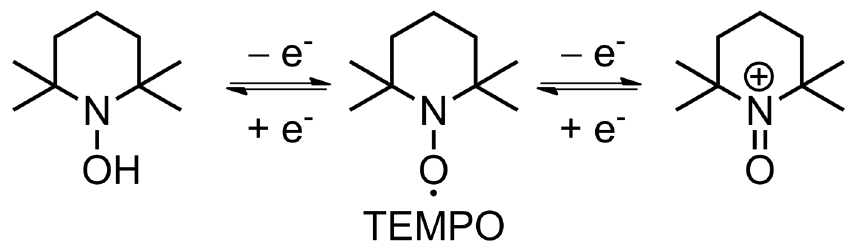
Figure 3. Schematic representation of redox couples of TEMPO radicals.